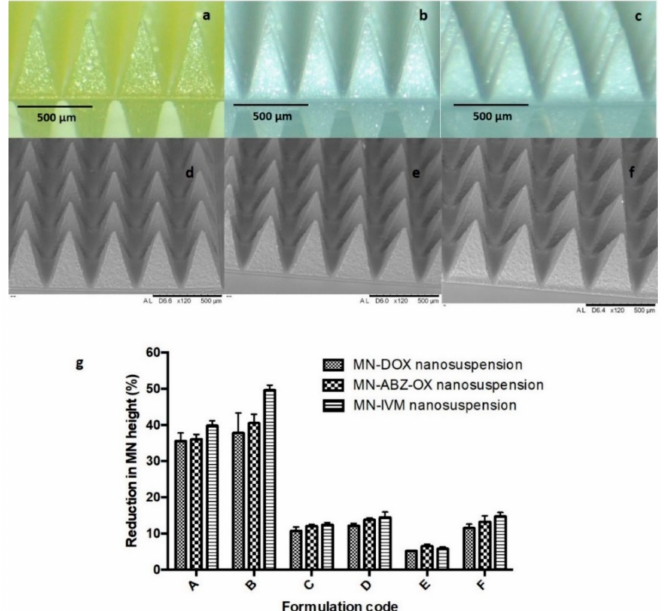
Figure 5. Light microscope images of the MN of Formulation E containing ( a ) 30% w / w of lyophilized NS of DOX, 15% w / w of PVA, and 5% w / w of PVP; ( b ) 30% w / w of lyophilized NS of ABZ-OX, 15% w / w of PVA, and 10% w / w of PVP and ( c ) 30% w / w of lyophilized NS of IVM, 15% w / w of PVA, and 10% w / w of PVP (C); SEM images of the MN containing drug NS of ( d ) DOX, ( e ) ABZ-OX, and ( f ) IVM (F); ( g ) Comparison of the percentage of height reduction of MN needles formulations containing 20% w / w of lyophilized NS of drugs and 50% w / w of PVP (formulation code A in each formulation); 30% of lyophilized NS of drugs and 50% of PVP (formulation code B in each formulation); 20% w / w of lyophilized NS of drugs and 15% w / w of PVA (formulation code C in each formulation); 30% w / w of lyophilized NS of drugs and 15% w / w of PVA (formulation code D in each formulation); 30% w / w of lyophilized NS of drugs and 15% w / w of PVA and 5% w / w of PVP (formulation code E in DOX formulation); 40% w / w of lyophilized NS of drugs and 15% w / w of PVA and 10% w / w of PVP (formulation code F in each formulation) (means ± SD, n =